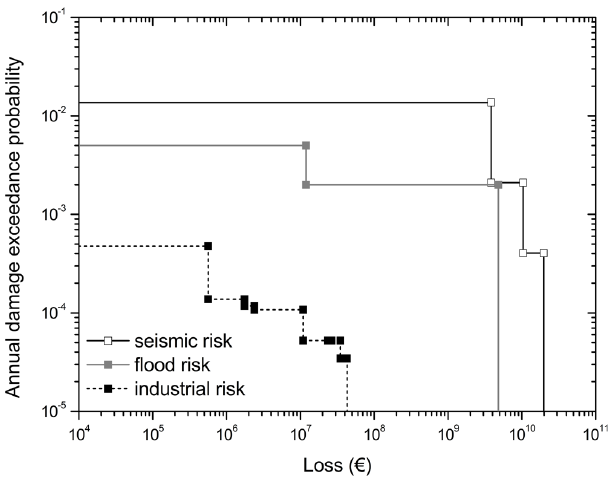
Fig. 13. Expected losses as a function of exceedance probability for the analysed scenarios. Expected losses are those provided by MC. Value of flood risk under the curve corresponds to 9643805 C (US- ACE, 2003 vulnerability model). Seismic risk equals 63897207 C (Kappos et al., 2006, vulnerability model), industrial risk is 2956 C.